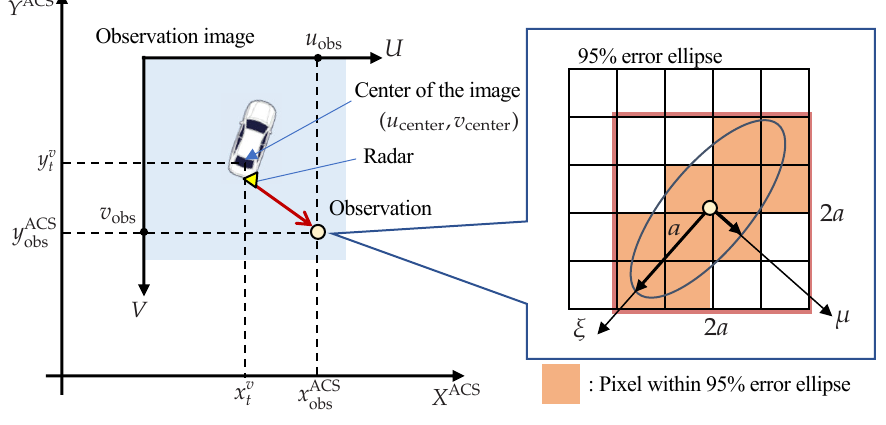
Figure 5. Mapping of a radar observation.